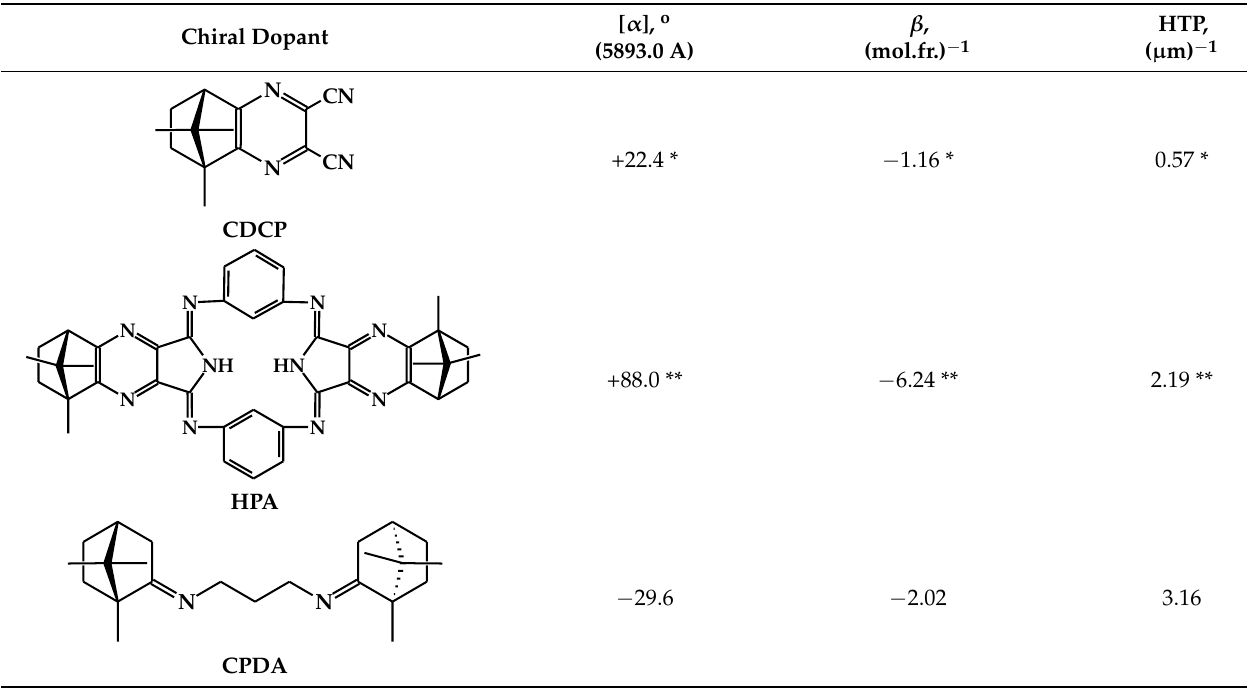
Figure 5. Fragment of the phase diagram of the CB-2+CPDA system ( a ) and dependence of HTP on the dopant concentration at 33 °C ( b ). Table 3. The specific optical rotation of camphor-containing chiral dopants and the degree of influence on the thermal stability and twisting efficiency of cyanobiphenyl nematic mixtures.